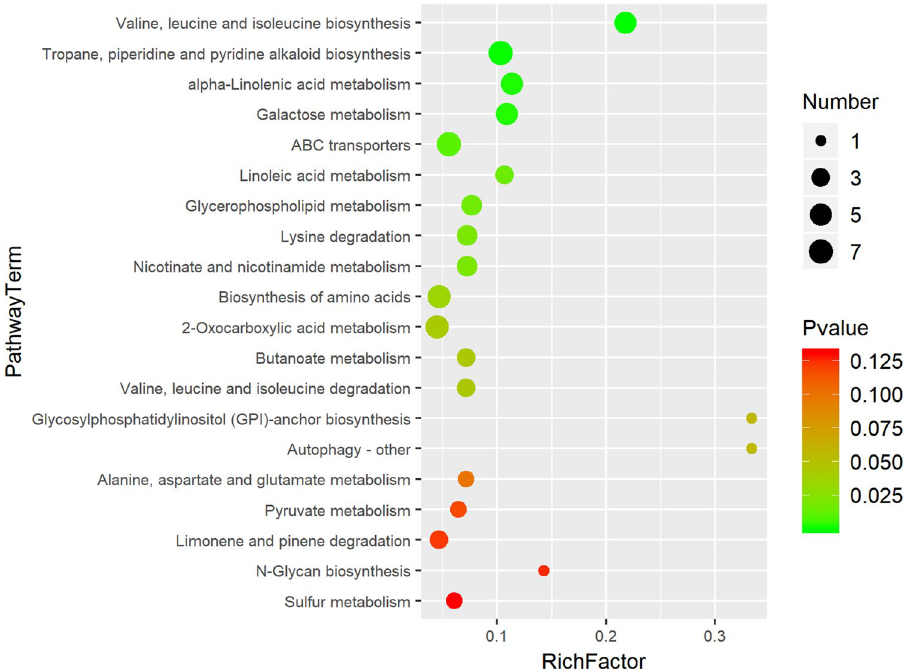
Figure 4. The top 20 enriched KEGG pathways under 0.6% NaCl stress for 48 h. The rich factor indicates the ratio of the number of DEMs in the pathway to the total number of DEMs in the pathway. A higher Rich factor indicates a greater degree of